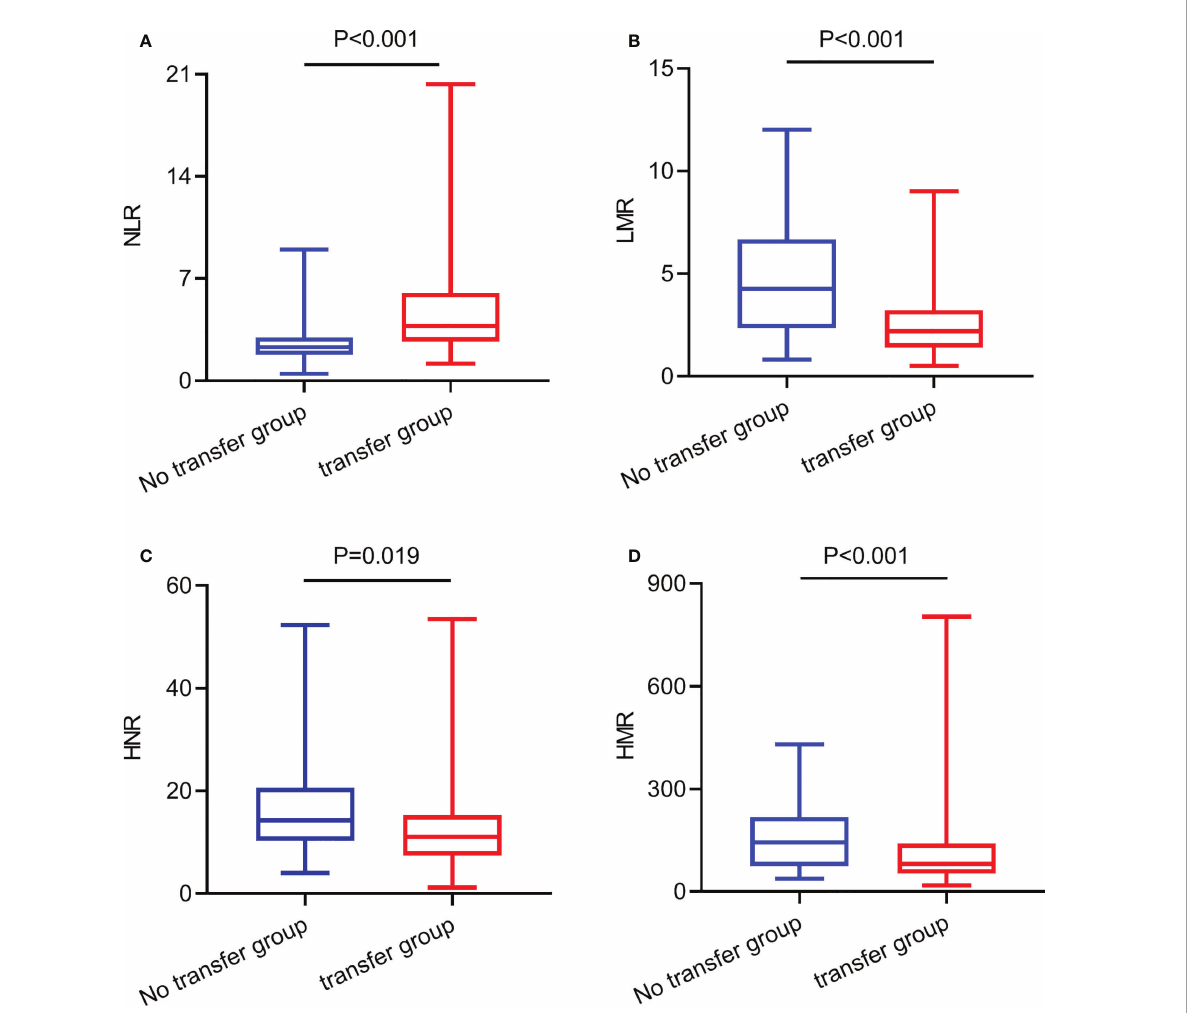
FIGURE 1 The expression levels of NLR, LMR, HNR, and HMR in metastatic and non-metastatic NSCLC patients. (A) The expression levels of NLR in metastatic and non-metastatic NSCLC patients. (B) The expression levels of LMR in metastatic and non-metastatic NSCLC patients. (C) The expression levels of HNR in metastatic and non-metastatic NSCLC patients. (D) The expression levels of HMR in metastatic and non-metastatic NSCLC